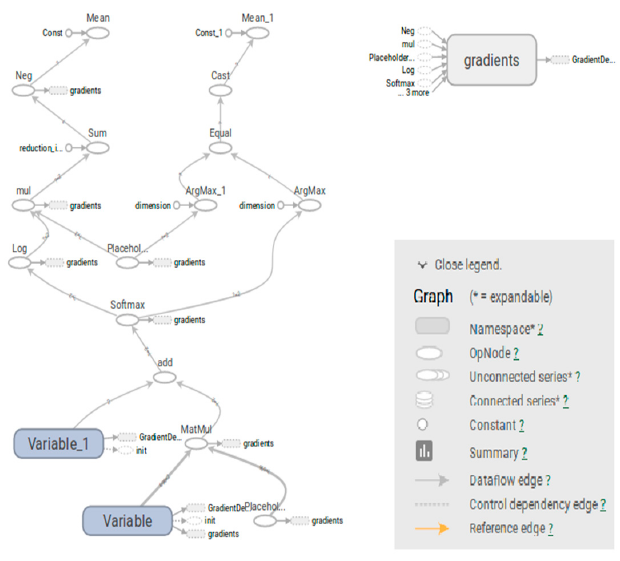
Figure 6. Structure using G-Descent.